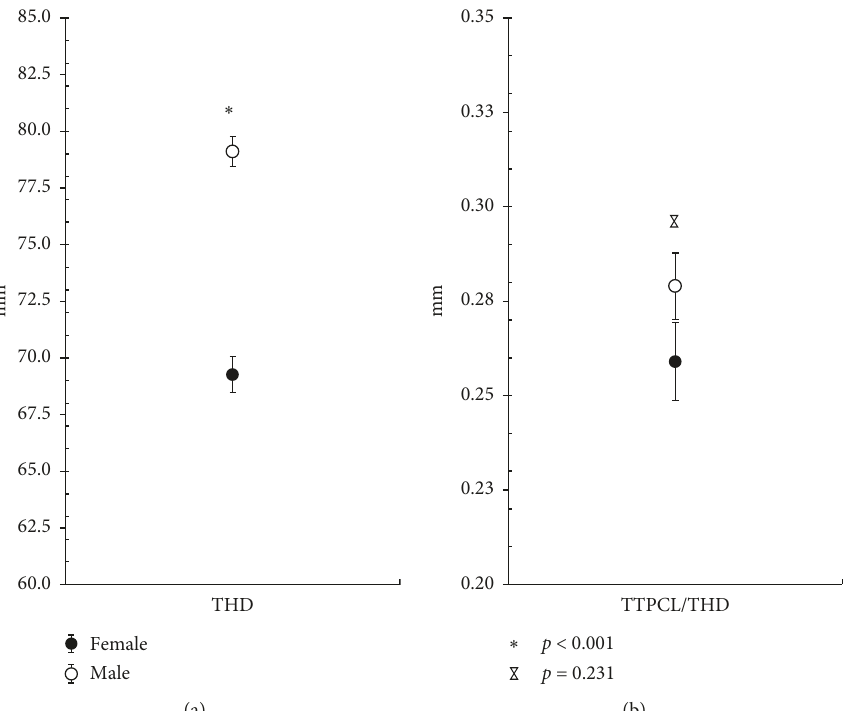
Figure 3: Graphs illustrating the THD and TTPCL/THD for healthy male and female adults. The results are expressed as the mean values of the group ±